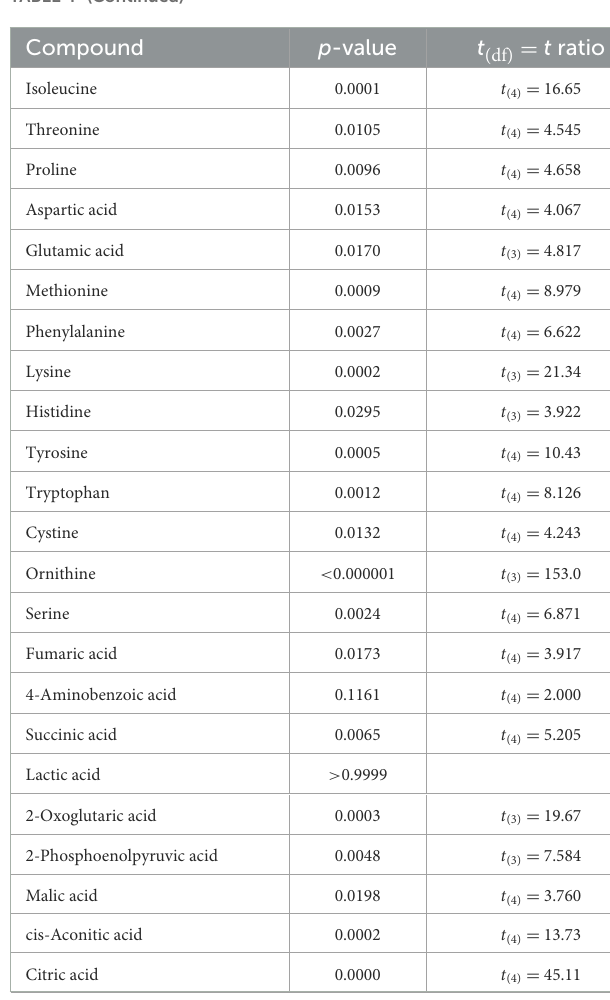
compared with L. rhamnosus GG [Figure 7, F (2,6) = 108.1, p < 0.0001].